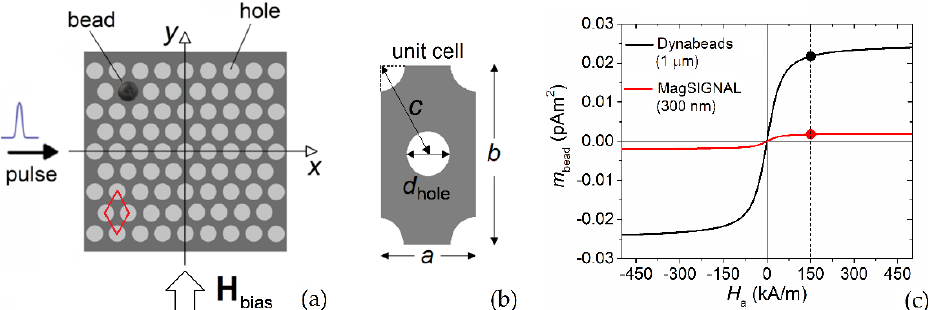
Figure 1. ( a ) Schematic of the permalloy nanostructured film (antidot array with rhomboid lattice structure). The schematic includes the configuration of the bias field and of the FMR excitation with a Gaussian pulse waveform. ( b ) Schematic of the unit cell of the antidot array, with relevant geometric parameters. ( c ) Magnetization curves of MagSIGNAL-STA and Dynabeads MyOne beads, fitted to the experimental data from the manufacturers. The dots indicate the magnetic moment values when a bias field of 150 kA/m is applied.